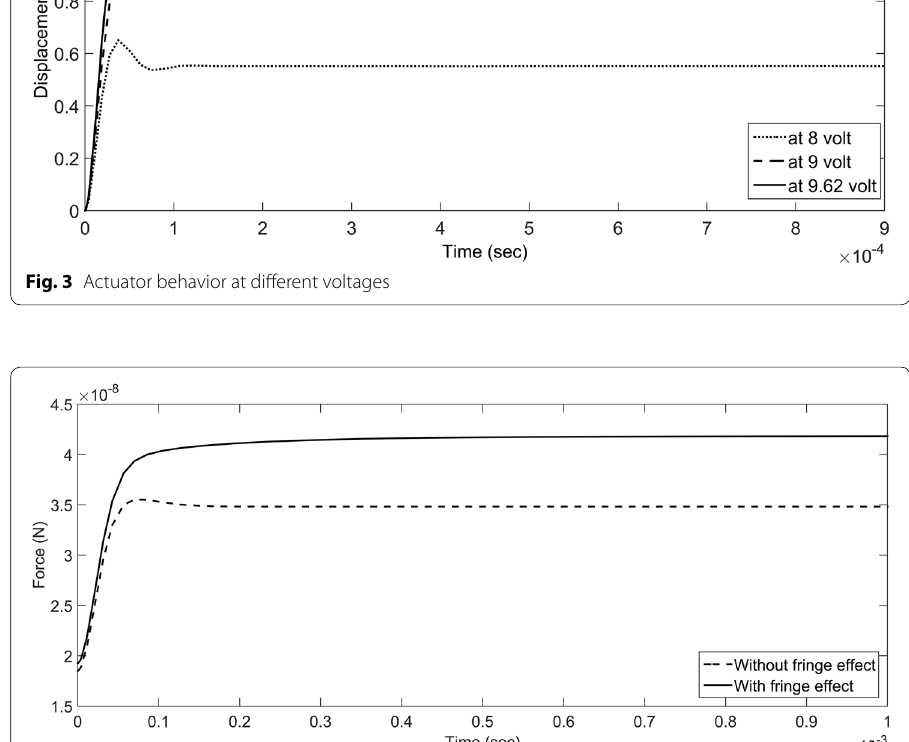
Fig. 4 Force at 8.18 V with and without considering fringe